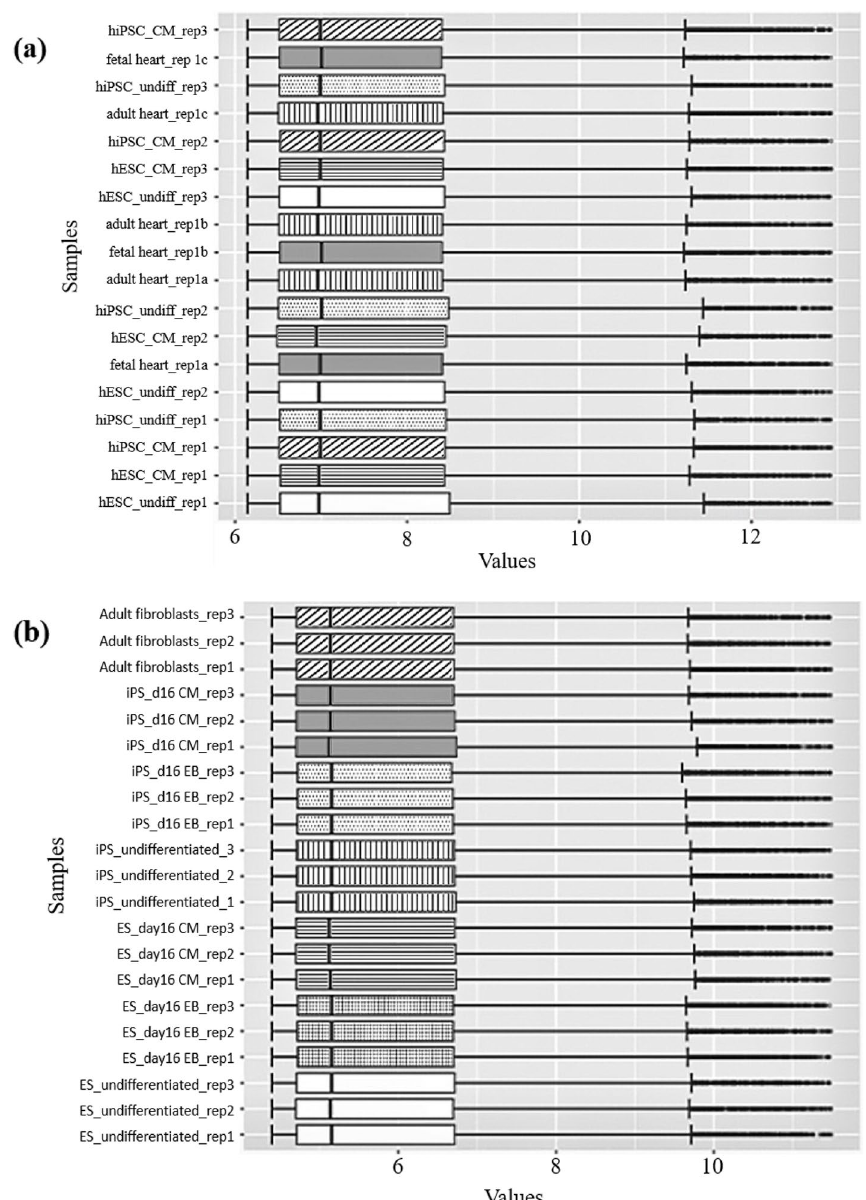
Fig. 1 Normalisation box plots- Box plots of normalised data sets of iPSCs and iPSC-CMs produced after the data was normalised in Network Analyst using a log2 transformation. Black lines in the boxes represent the median values. a the human data set, GSE17579. b mouse data set,